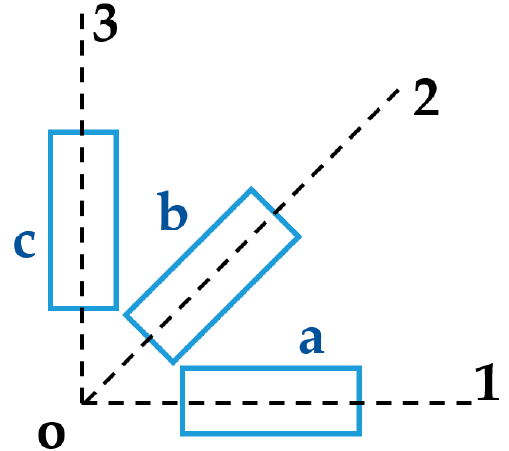
Figure 10. Schematic showing three strain gauges (a, b, c) aligned with three axes (1, 2, 3).